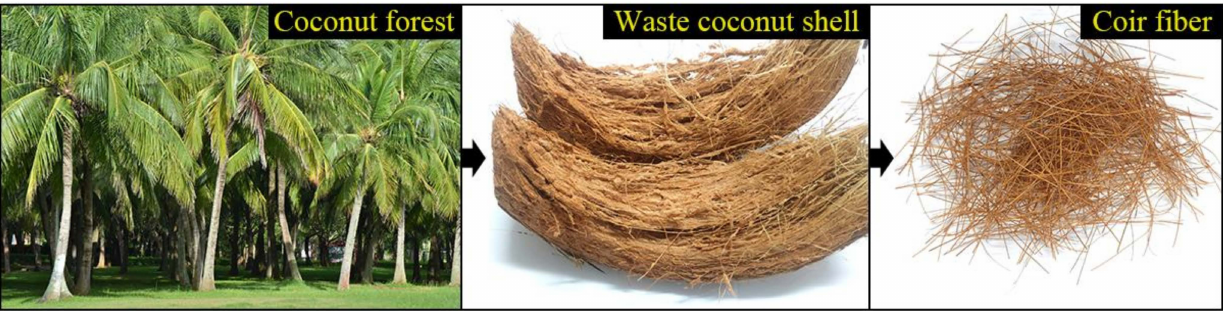
Figure 1. Coconut forest, waste coconut shell and coir